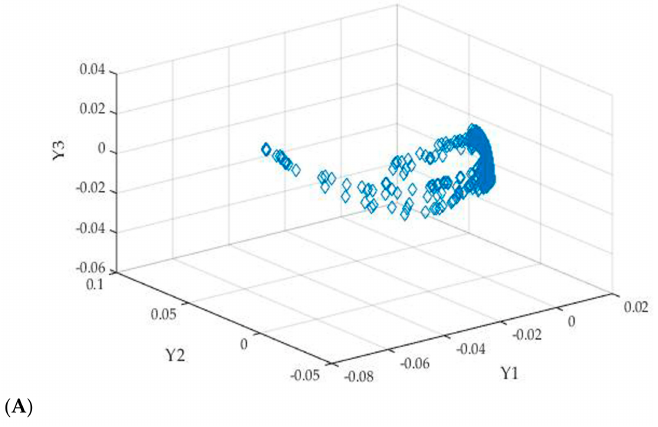
Figure 3. Image pixels colored according to the RGB color associated with the first three coordinates of the diffusion map (the coloring is only for displaying purposes). ( A ) Diffusion map (DM) calculated with all of the image data. ( B ) DM calculated with sampled image data, where the random sampling rate is 0.8. ( C ) DM calculated with sampled image data, where the random sampling rate is